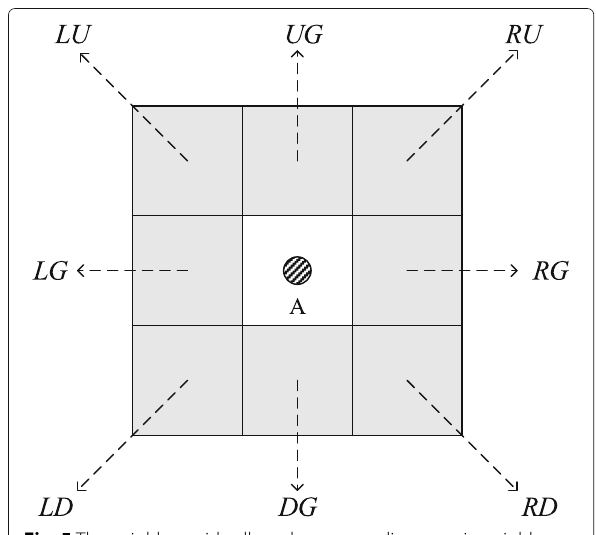
different moving belt grids for different durations accord- ing to the collected sensory data. The mobile sink assigns weight values to the moving belt grids, and the weight val- ues affect the parking time of a mobile sink. When the mobile sink completes Num cycle moving cycles in the cur- rent moving belts, it estimates the location of the event region. Subsequently, the moving belts switch according to the corresponding strategy.